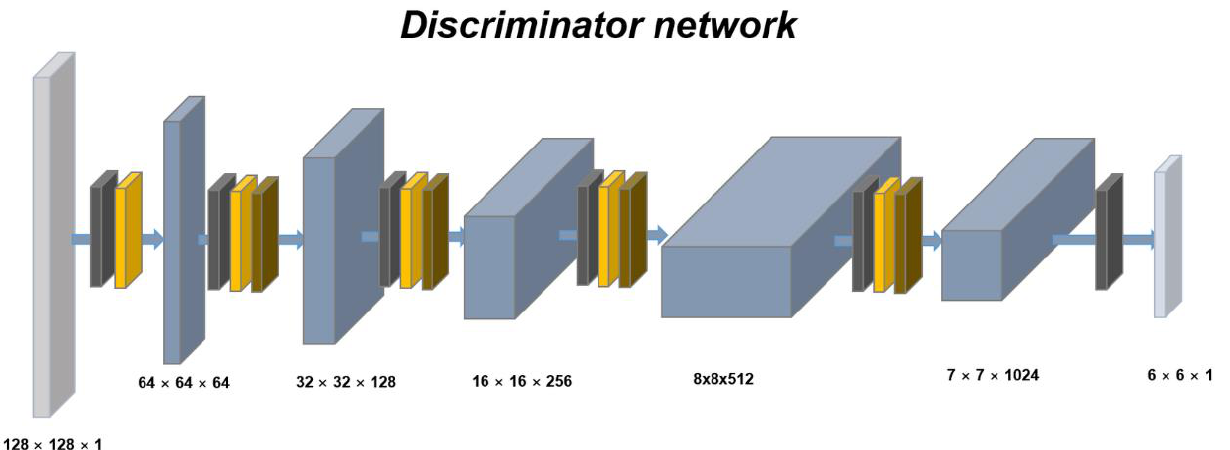
Figure 3. Model architecture of the discriminator for generating synthetic MR images from lumbar spine CT. The generator used a PatchGAN discriminator. Each number of the feature maps is the width, height, and channels of the feature map. The layers for networks were constructed by the color boxes. MR, magnetic resonance; CT, computed tomography.